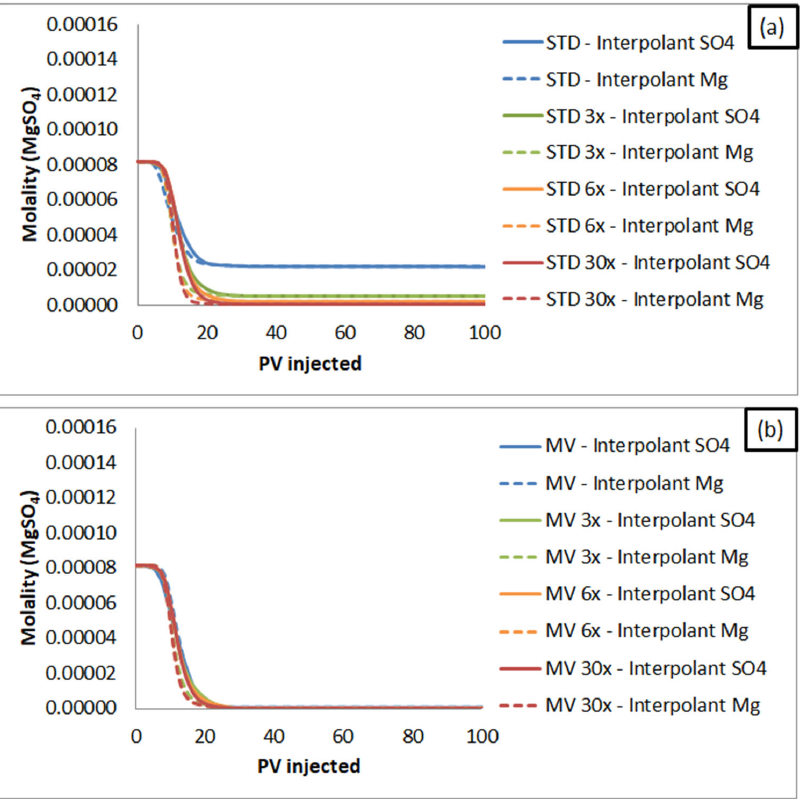
Figure 8. MgSO 4 concentration in the effluent for brine injection: ( a ) STD; ( b ) MV and ( c ) DV. Concerning another physicochemical alteration in the porous medium, Figure 9 shows the pH variation in the effluent as a consequence of the processes that are taking place in the core during smart water injection. Figure 9 shows an increase in the pH of the effluent during the injection for all simulated scenarios, which indicates that the recovery process was adequately described. This increase is also a critical alteration during smart water flooding, observed in most experimental studies. Some authors consider pH one of the main factors leading to wettability alteration [39]. Calcite, one of the main minerals observed in carbonate reservoirs, tends to have a more negative surface charge with pH